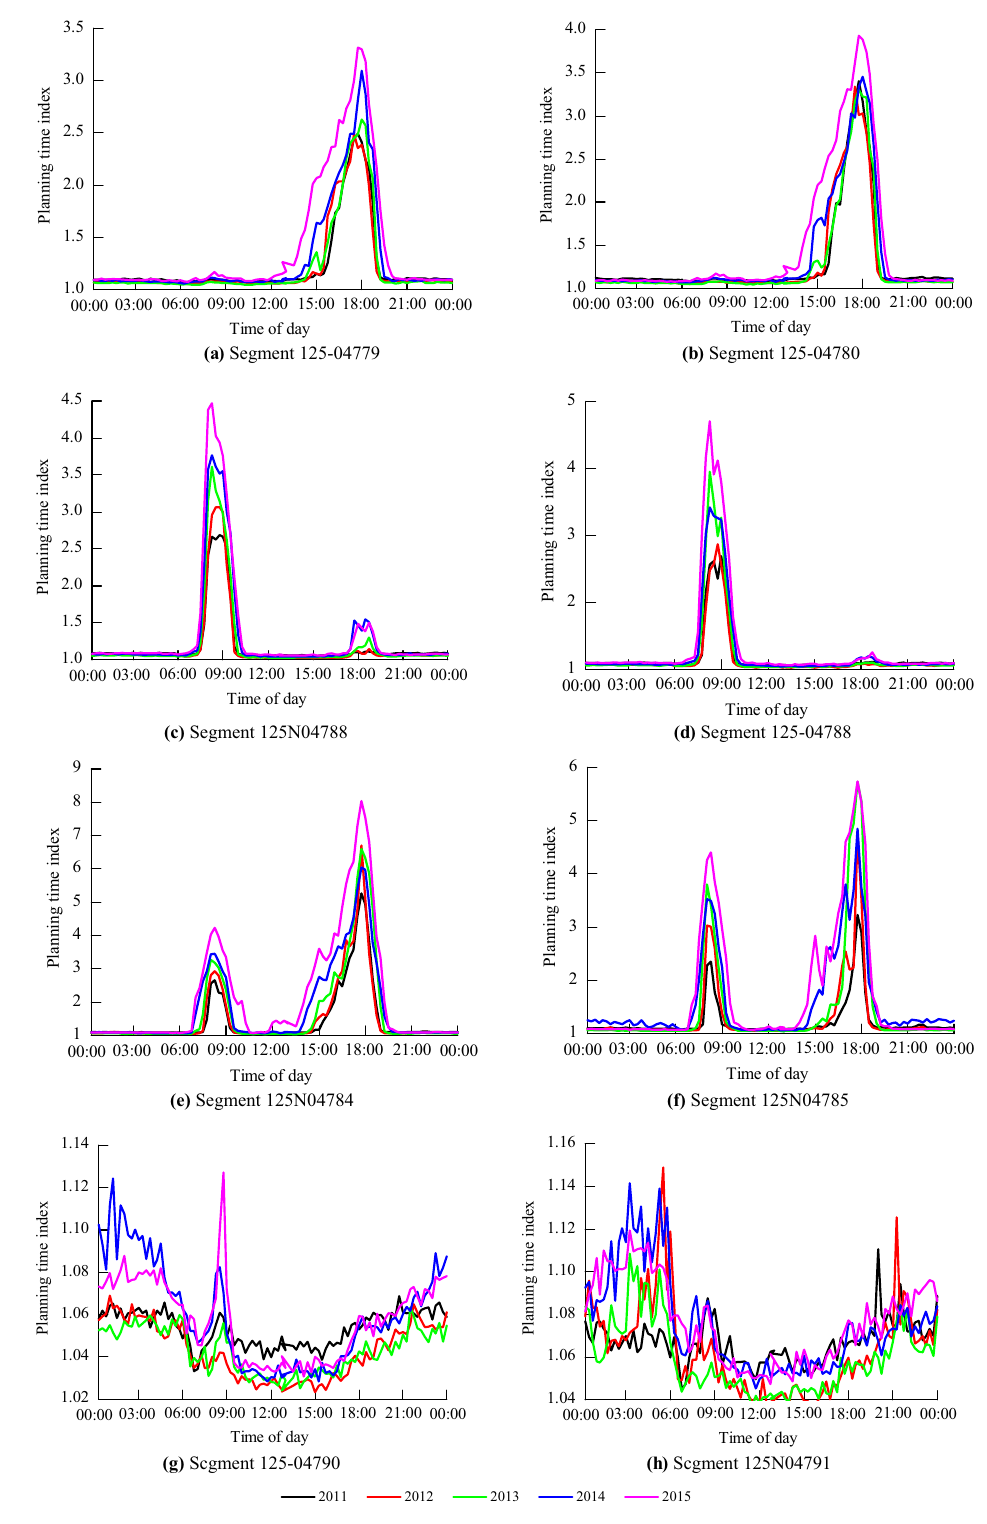
Fig. 4 TTR variability pattern of each segment in 5